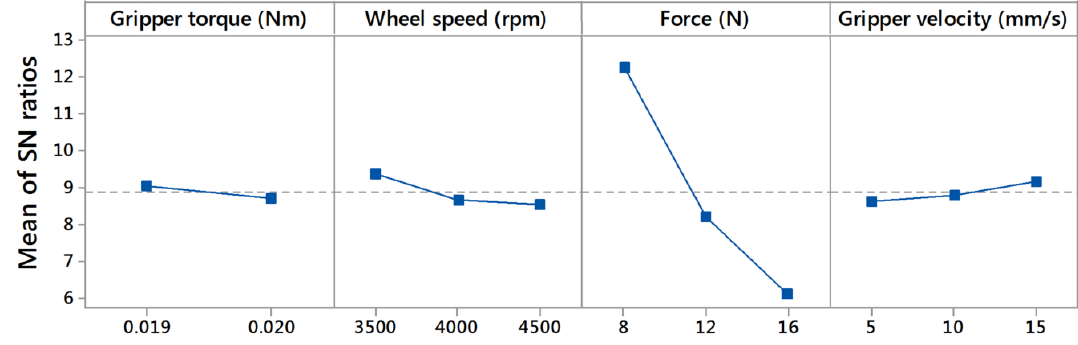
Figure 7. Main e ff ects plot of SN ratios for torque. Figure 7. Main effects plot of SN ratios for torque. Figure 7. Main effects plot of SN ratios for torque.